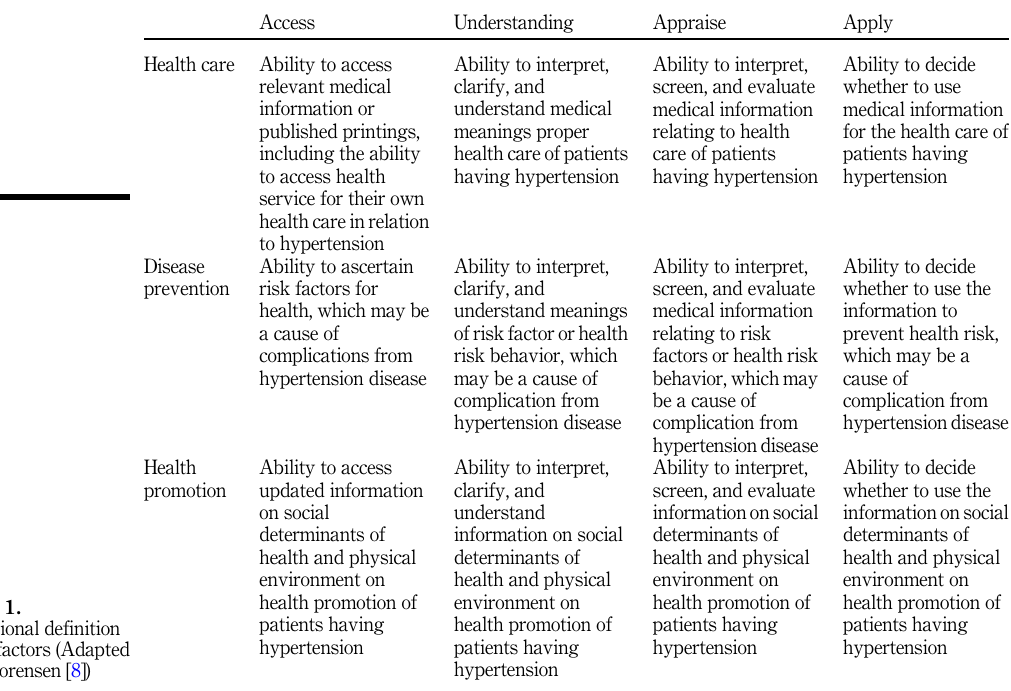
Table 1. Operational definition of the factors (Adapted from Sorensen